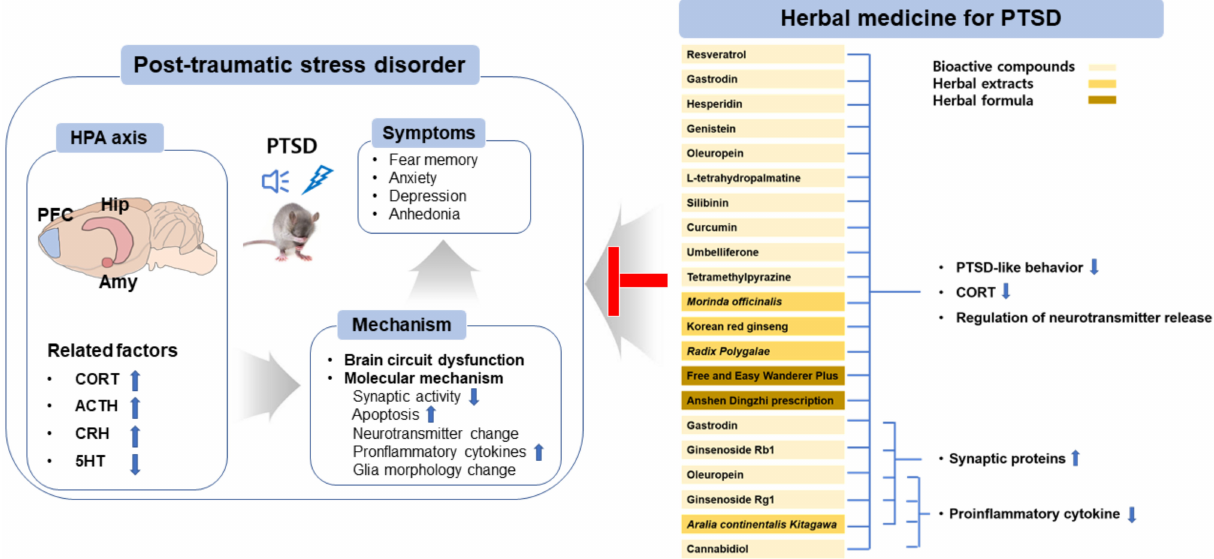
Figure 1. Overview of the pharmaceutical intervention based on herbal medicine for treating PTSD. Abbreviations: hypothalamic–pituitary–adrenal axis (HPA axis); prefrontal cortex (PFC); hippocam- pal (Hip); amygdala (Amy); corticotropin releasing hormone (CRH); adrenocorticotropic hormone (ACTH); corticosterone (CORT); serotonin (5-hydroxytryptamine (5-HT)); brain-derived neurotrophic factor (BDNF); cAMP response element-binding protein